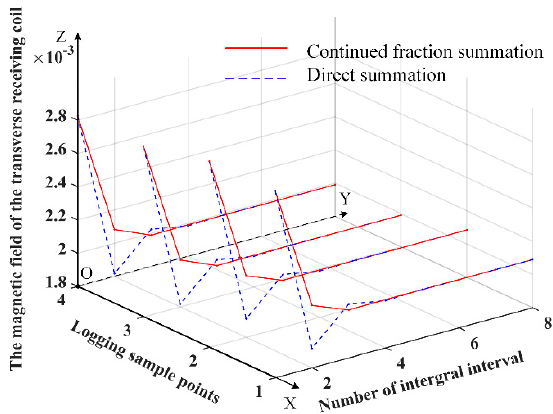
Figure 2. The results of the magnetic field responses on the axial receiving coil with the number of integral intervals.